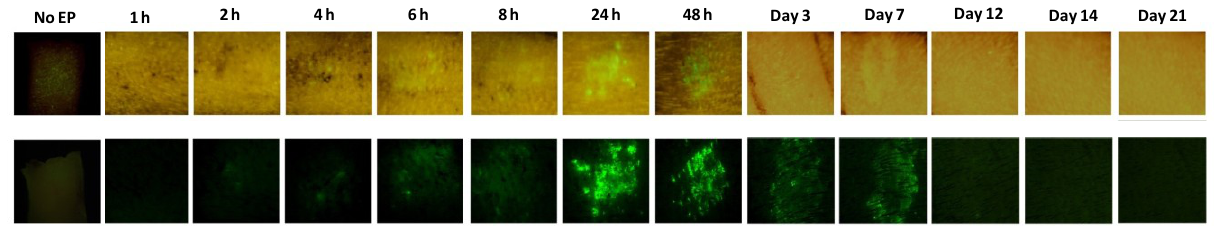
Figure 1. Gene delivery enhanced by dermal electroporation induces sustained expression on the surface of the skin. Time course (1 h post treatment to day 21) of green fluorescent protein (GFP) expression after intradermal (ID) plasmid administration followed by surface electroporation (SEP) in guinea pig skin visualized under natural (top panel) and fluorescent (lower panel) light. An untreated control is also shown. Photos are representative examples of multiple